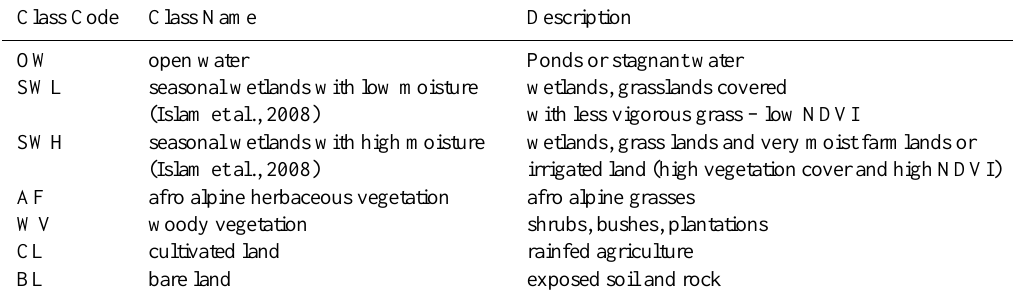
Table 4. Descriptions of the land cover classes identified in the Mt. Choke